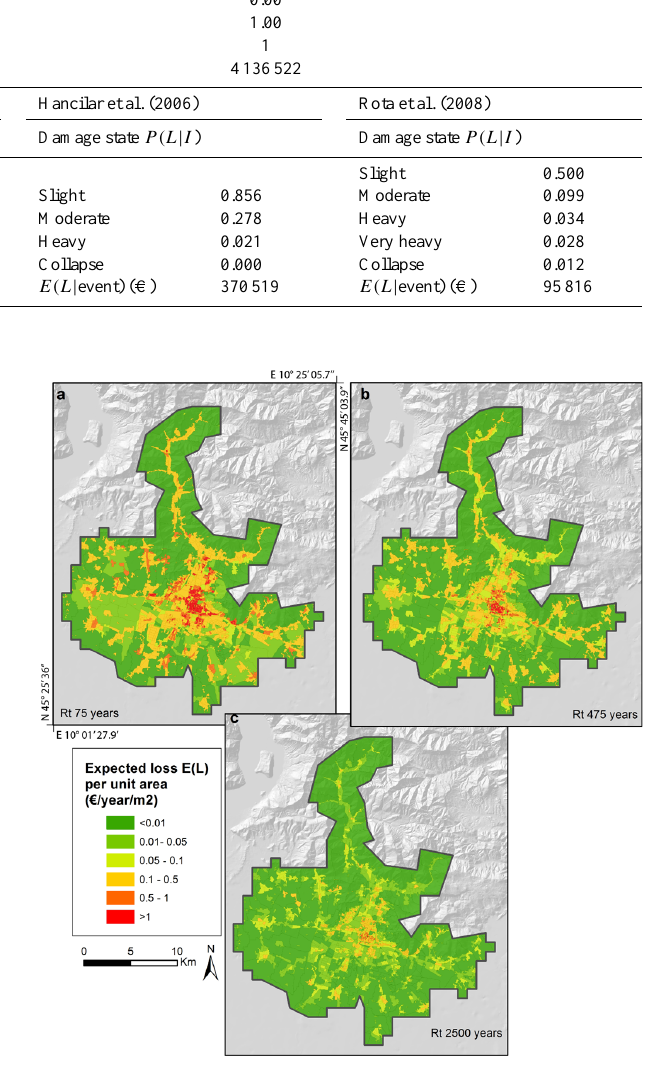
Fig. 9. Seismic economic risk values for FOSM analysis, with Kap- pos et al. (2006) vulnerability model, computed for (a) 75-yr sce- nario, (b) 475-yr scenario and (c) 2500-yr